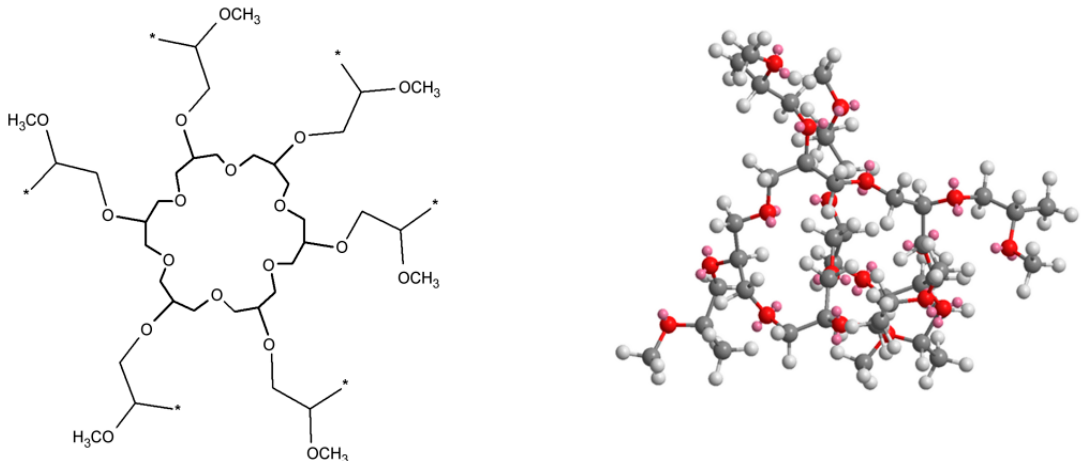
Figure 8. Structures of studied polymer—S XVII Mn = 6450, D = 1.45.